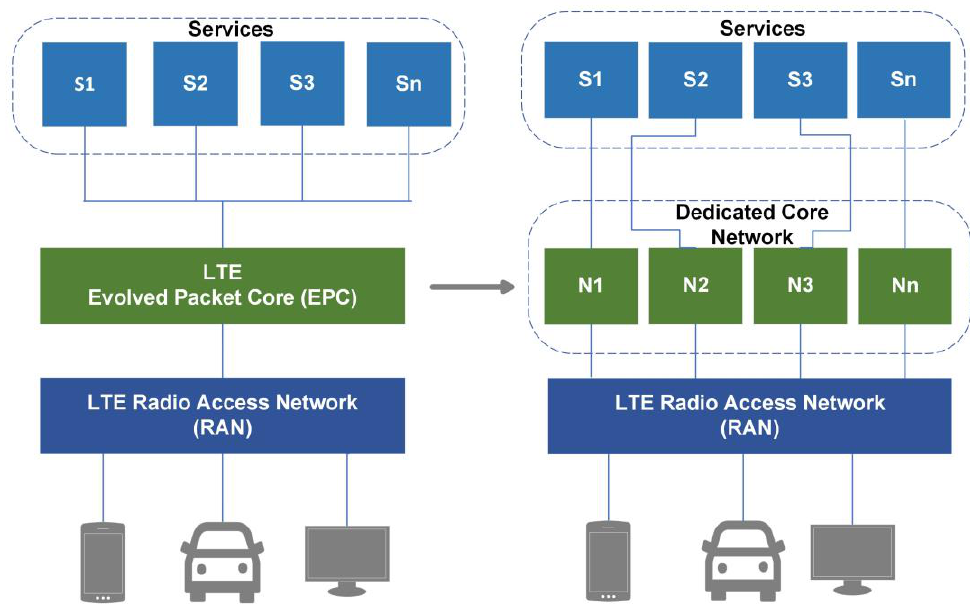
Figure 1. Evolution of NGWNs (multiple services sharing one link to 4G framework for dedicated core selection based on user equipment (UE)).